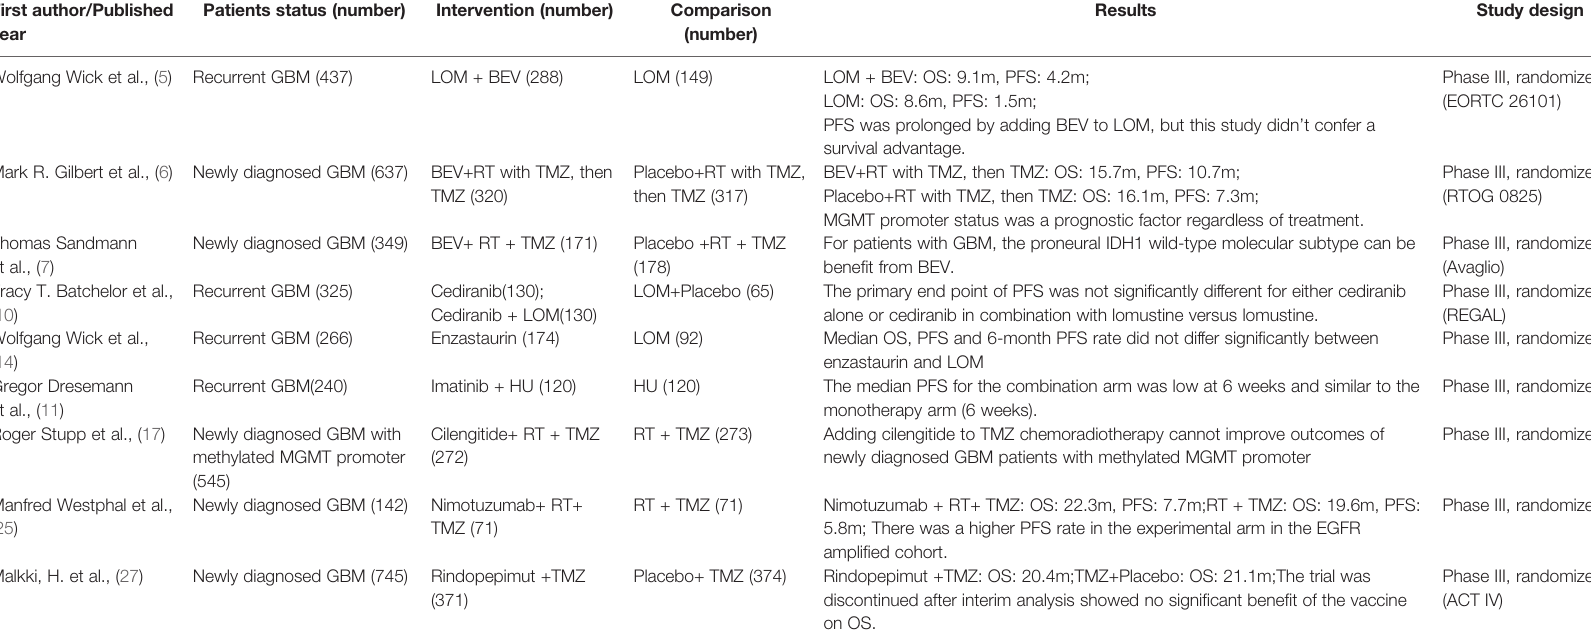
TABLE 1 | Characteristics of imposing phase III clinical crials for